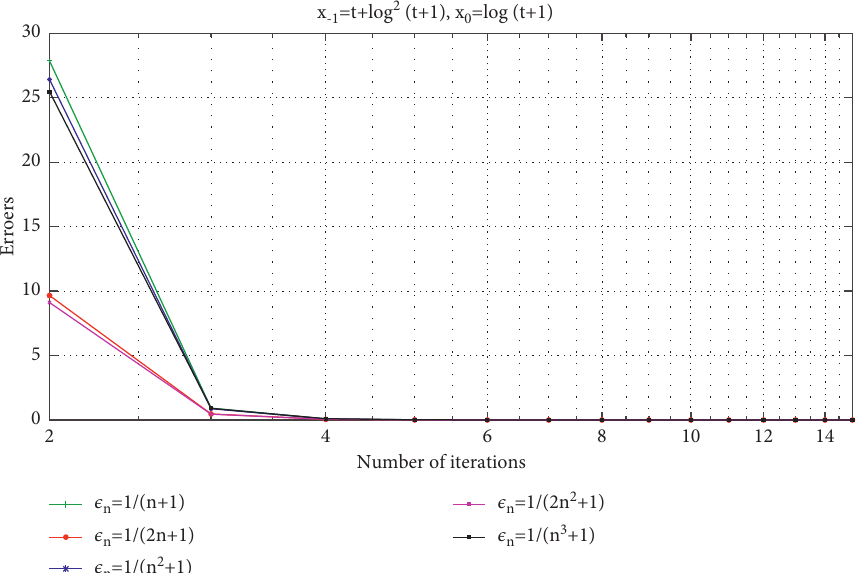
Figure 3: The Cauchy error plotting number of iterations for different parameters ε